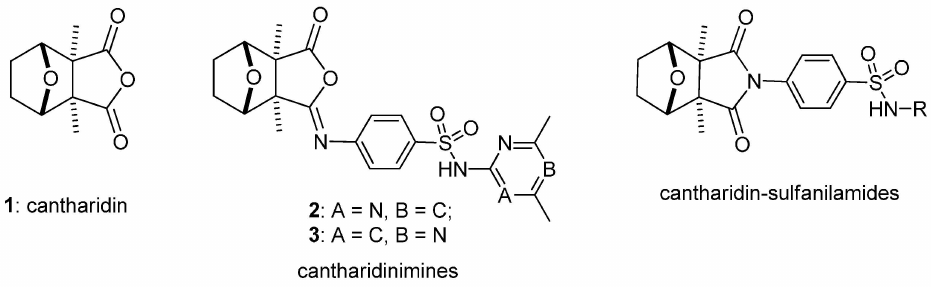
Figure 1. Structures of cantharidin ( 1 ), cantharidinimines ( 2 , 3 ), and